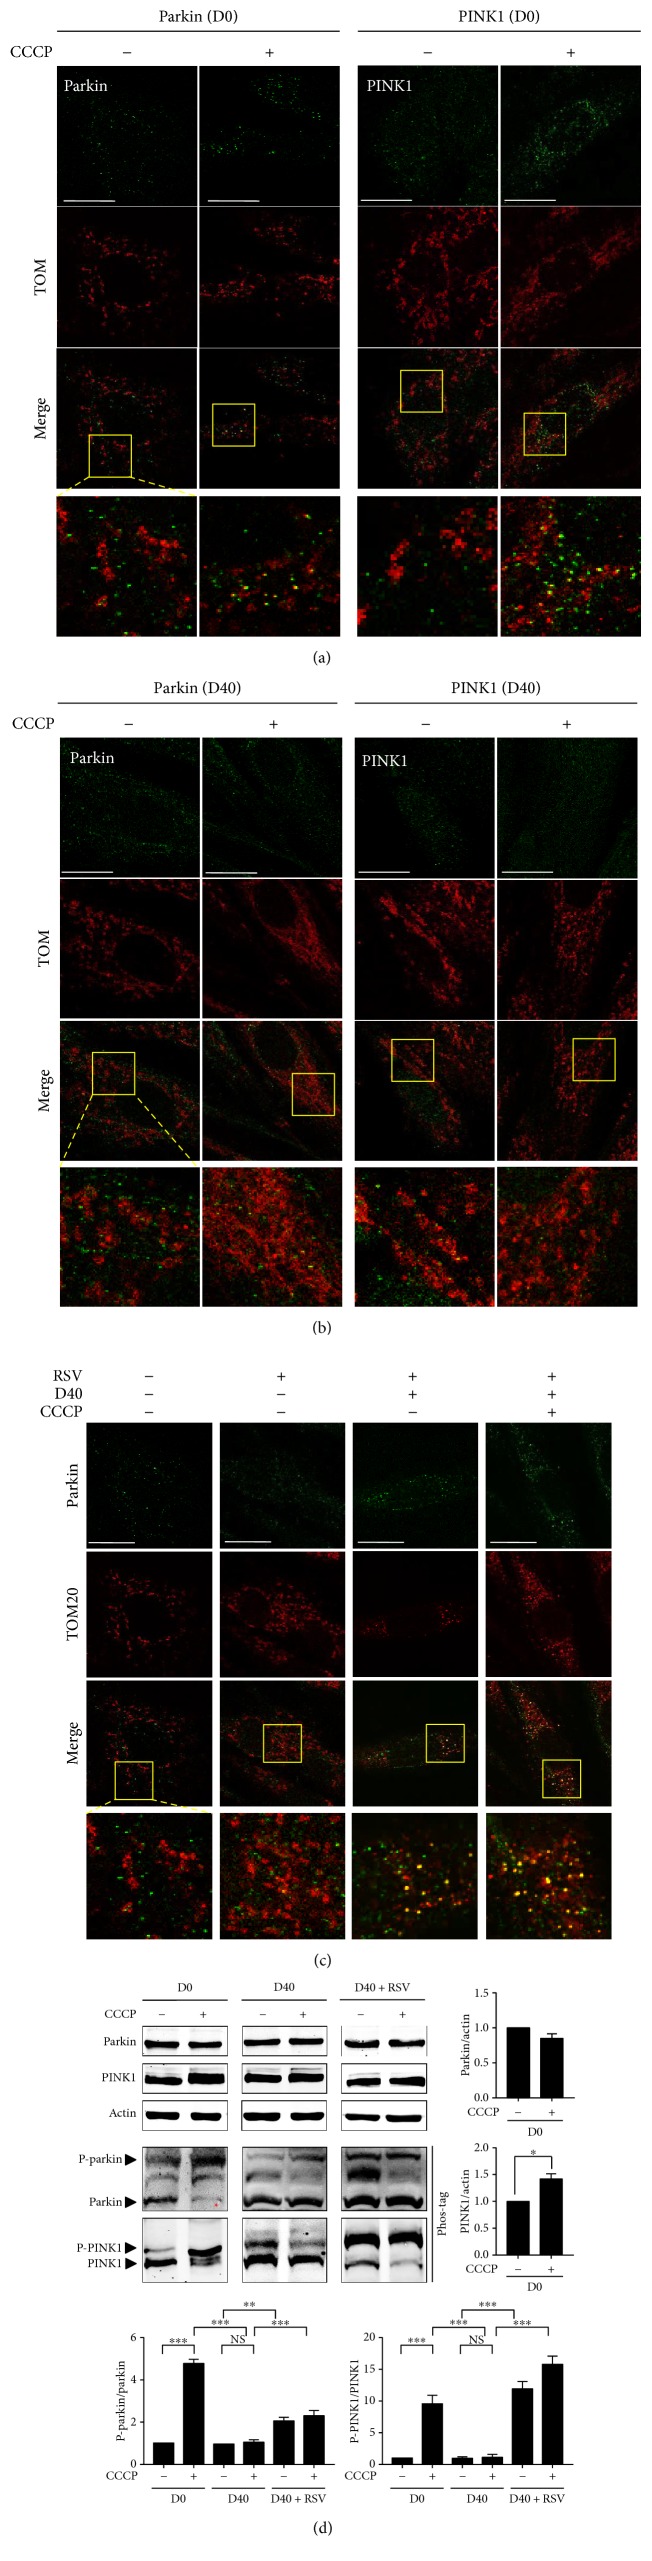
Resveratrol regulated the activity of parkin/PINK1 signaling upon mitochondrial depolarization in H9c2 cells in response to D-galactose induction. (a, b, c) Parkin and PINK1 expressions were detected using confocal microscopy by immunofluorescence analysis; objective magnification, 63x; scale bar represents 20 μm. Colocalization of parkin (or PINK1) (green) and TOM20 (red) was shown in magnified images. The yellow fluorescence represented the overlap of red and green fluorescence. (d) Parkin and PINK1 protein expressions were detected by immunoblot analysis and calculated. Actin was represented as the loading control. Phosphorylation of parkin and PINK1, respectively, was detected by immunoblot analysis with phos-tag and incubated with anti-parkin and anti-PINK1 primary antibodies. The upper binds (slow migration binds) indicated by the black arrow showed phosphorylated proteins. Data (n = 3) were shown as the mean ± SEM (∗p < 0.05, ∗∗p < 0.01, and ∗∗∗p < 0.001).